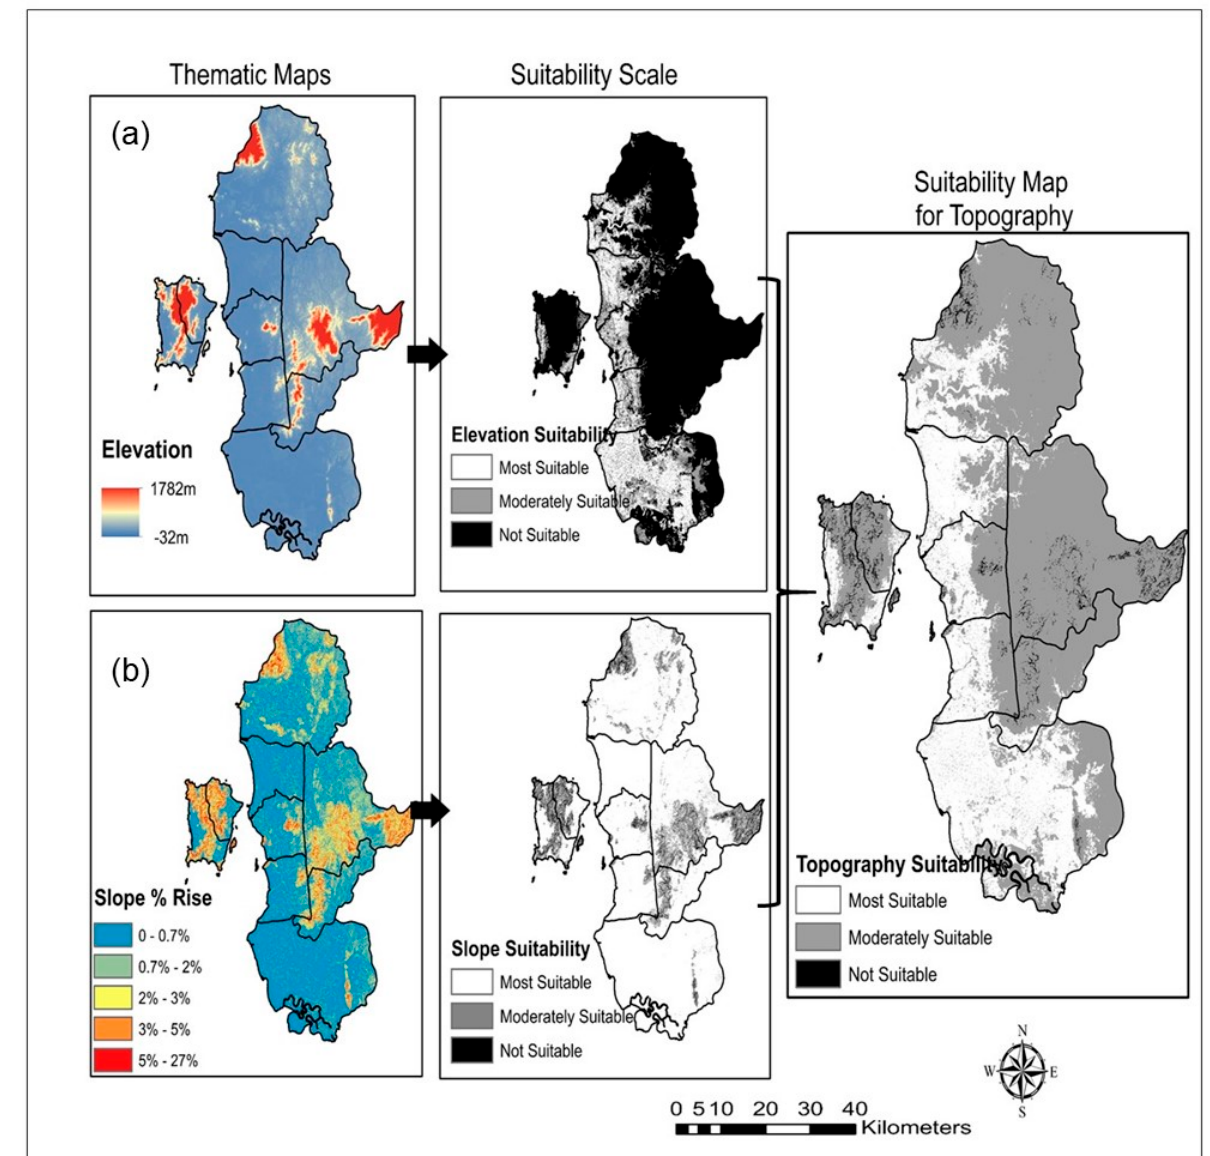
Figure 4. Process of producing a suitability soil condition map from ( a ) elevation, and ( b ) slope rise.